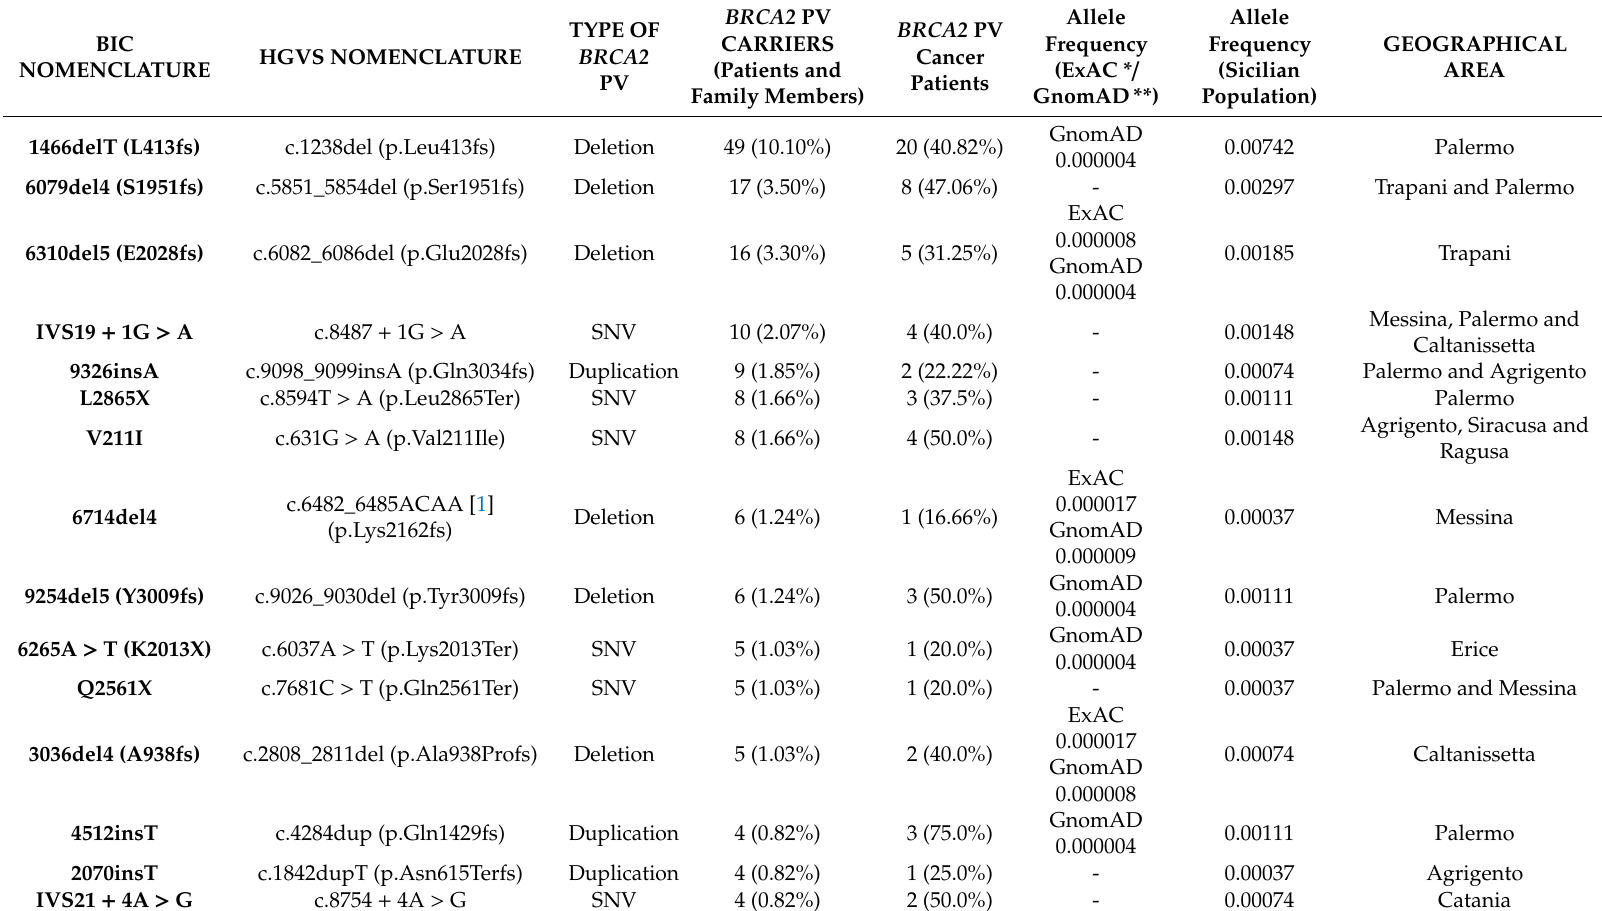
Table 4. Type and Frequency of Germline BRCA2 PVs (class V) and Geographical Area of Origin of BRCA